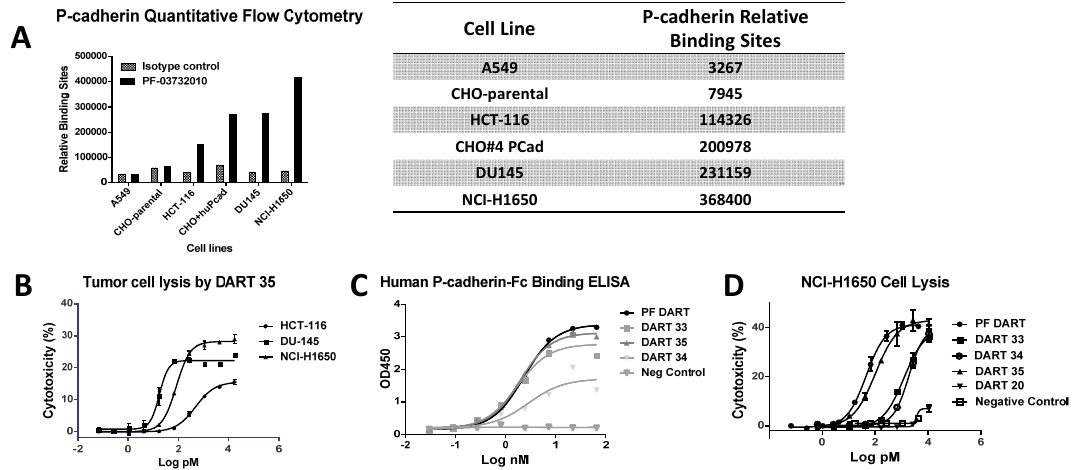
Figure 2. ( A ) Quantitative flow cytometry using phycoerythrin (PE) ‐ conjugated anti ‐ P ‐ cadherin [20] at a fluorophore ‐ to ‐ protein ratio of 1:1. Relative antibody binding sites correlating to the number of antigens on the cell surface were determined using Quantum Simply Cellular Kit (Bangs Laboratories); ( B ) Graphical Cytotoxic T Lymphocyte (CTL) assay results of DART 35 on HCT ‐ 116, DU145 and NCI ‐ H1650 cells; Graphical representation of ( C ) protein binding enzyme ‐ linked immunosorbent assay (ELISA) and ( D ) NCI ‐ H1650 adenocarcinoma CTL Assay. Specific binding activity of the anti ‐ P ‐ cadherin/anti ‐ CD3 DART proteins was determined using dose ‐ dependent binding ELISAs and/or surface plasmon resonance (SPR) assays run on a Biacore